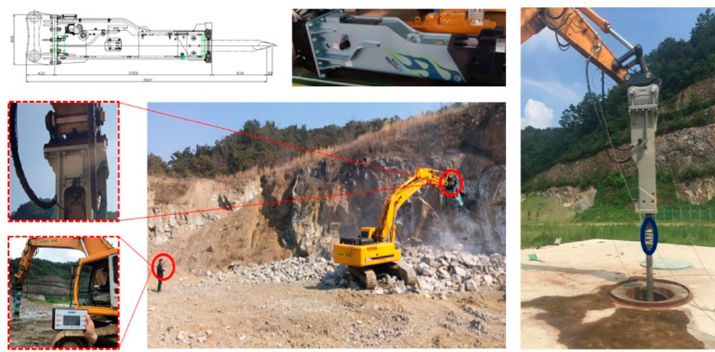
Figure 9. Control system and site for the experiment; the blue circle indicates the strain gauge.